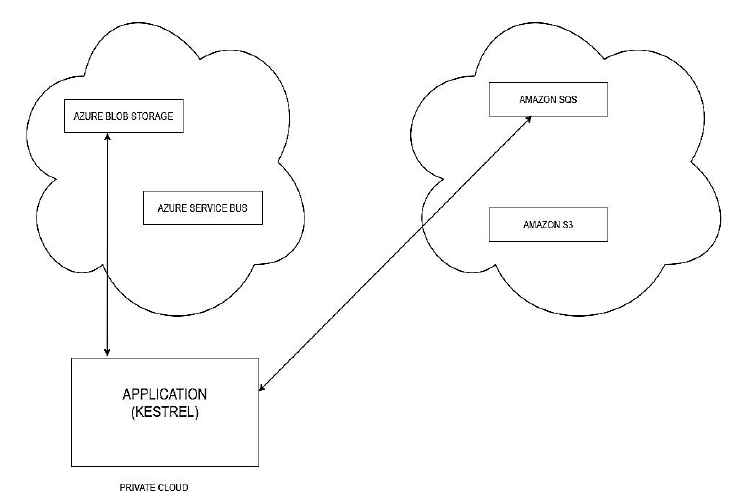
Figure 7. Hybrid cloud scenario.